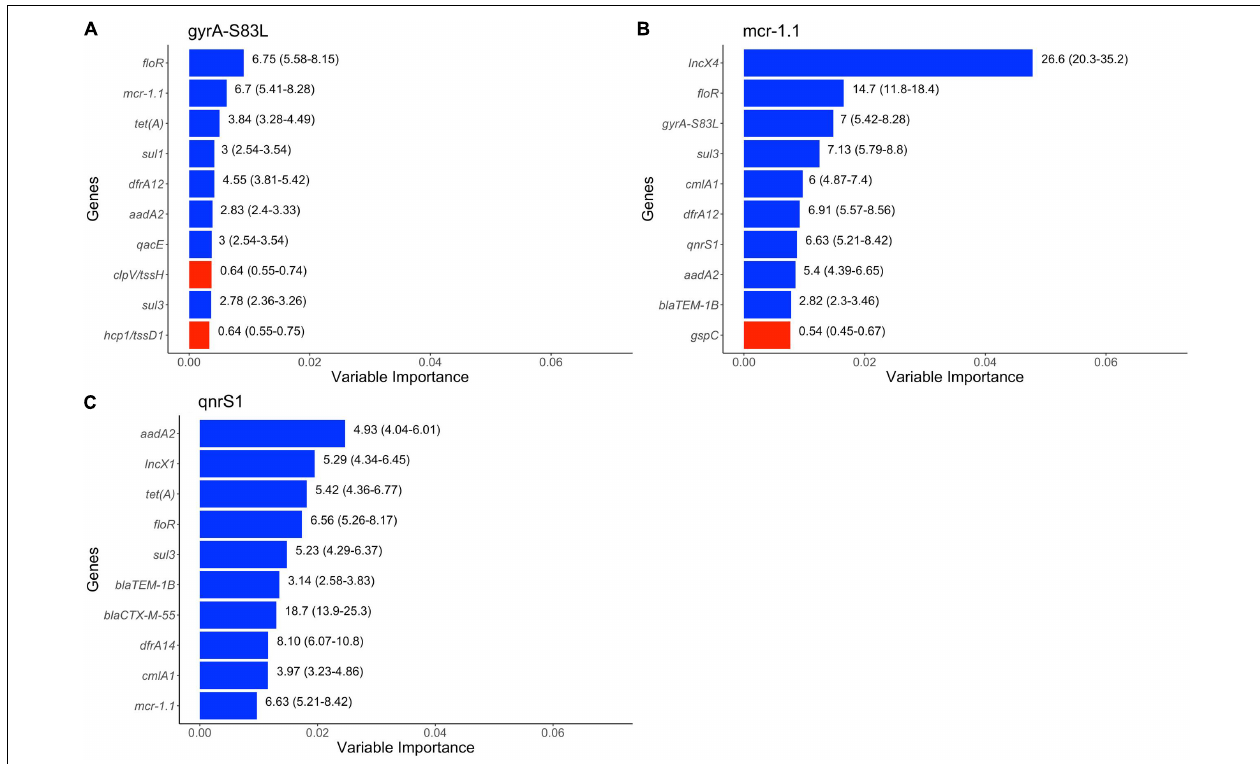
FIGURE 5 | Top 10 variables of importance predictive of (A) gyrA- S83L mutation, (B) mcr1.1 and (C) qnrS1 in publicly available E. coli genomes of swine origin. Colors of bar represent positive (blue) and negative (red) association based on unadjusted odds ratio. The numbers on the right side of the bars represent unadjusted odds ratios (95% confidence